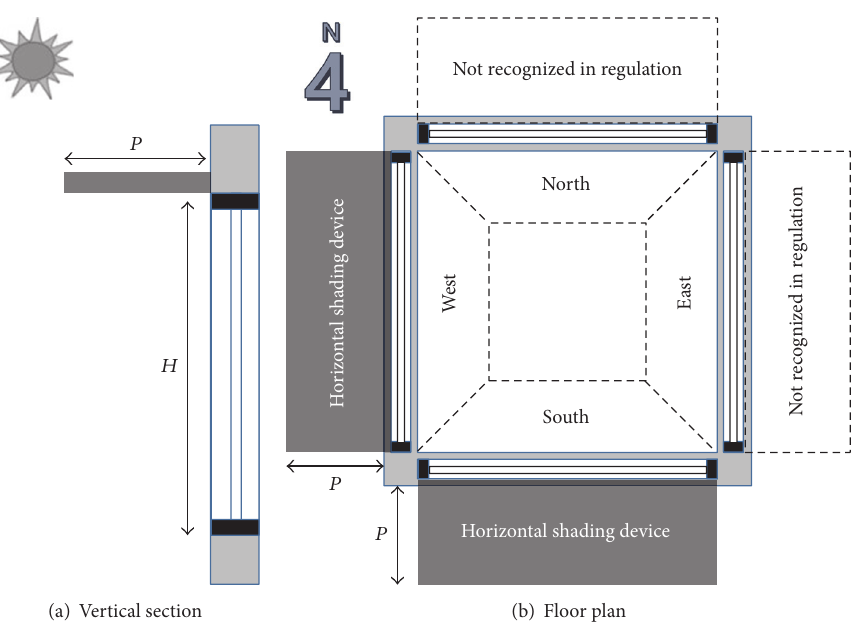
Figure 6: Plan view of permission range of horizontal shading device in